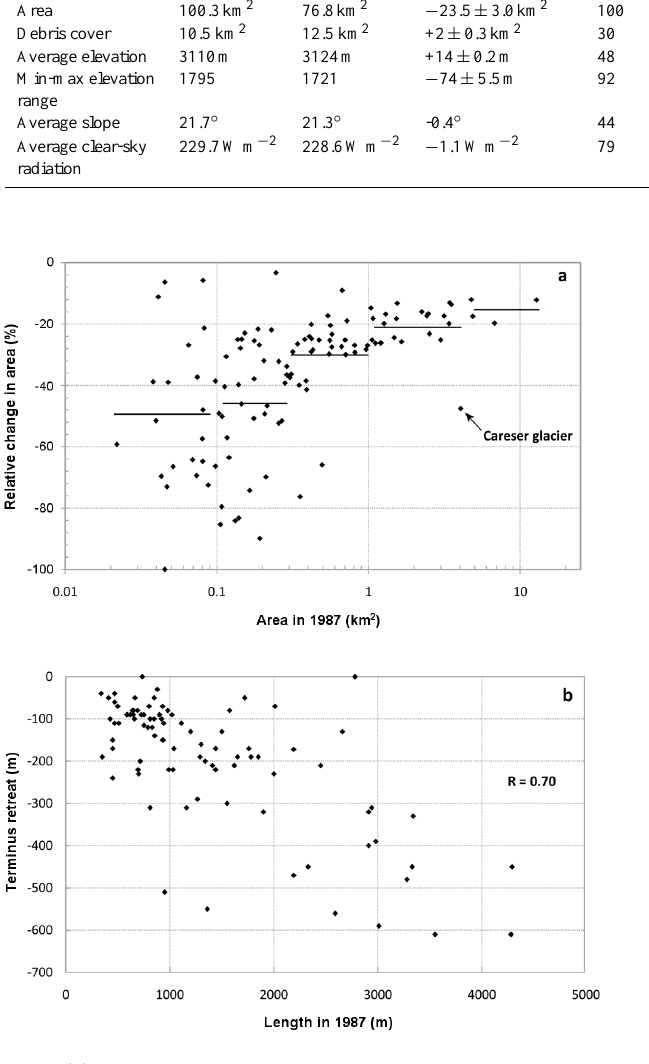
Fig. 7. (a) Relative change in area vs. initial area in 1987. Horizontal Fig. 7. a) Relative change in area vs. initial area in 1987. Horizontal lines show mean values for lines show mean values for distinct size classes. (b) Terminus retreat distinct size classes. b) Terminus retreat vs. initial length in 1987. vs. initial length in